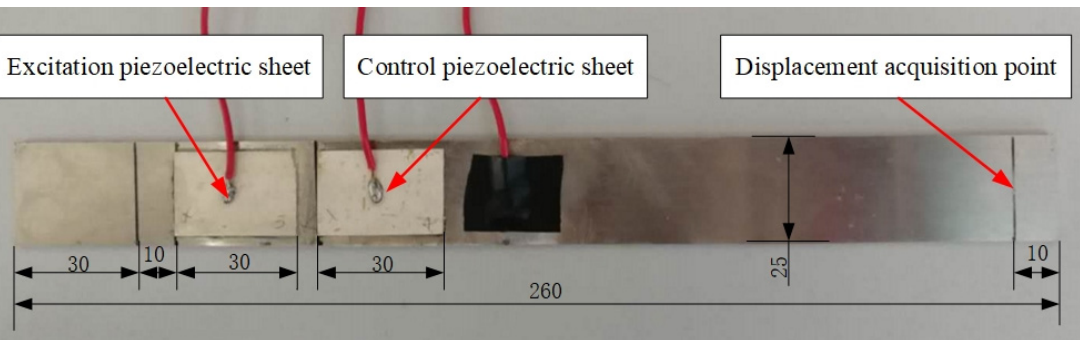
Figure 4. Structure of the cantilever beam.